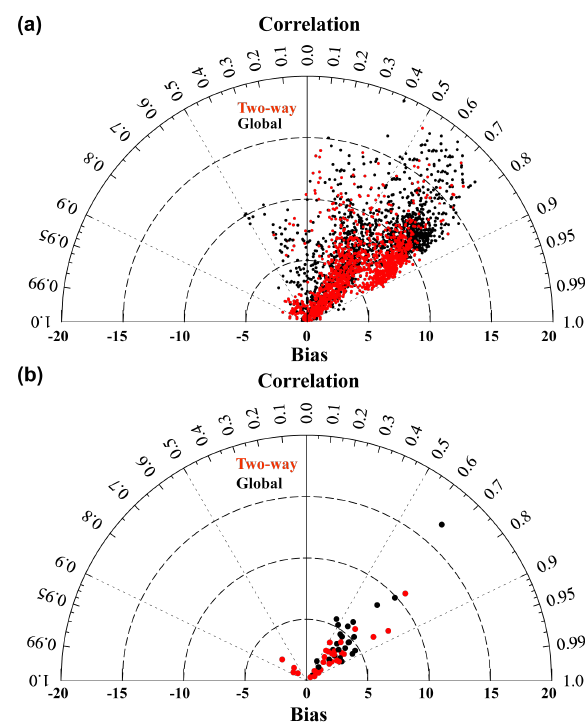
Figure 6. (a) Mean bias and day-to-day correlation of afternoon (12:00–18:00LT) mean ground-level ozone for model simulations with respect to measurements from WDCGG, GMD, EMEP and AQS (a total of 1420 sites). (b) Similar to panel (a) but with respect to measurements outside the three nested domains from WDCGG and GMD (a total of 25